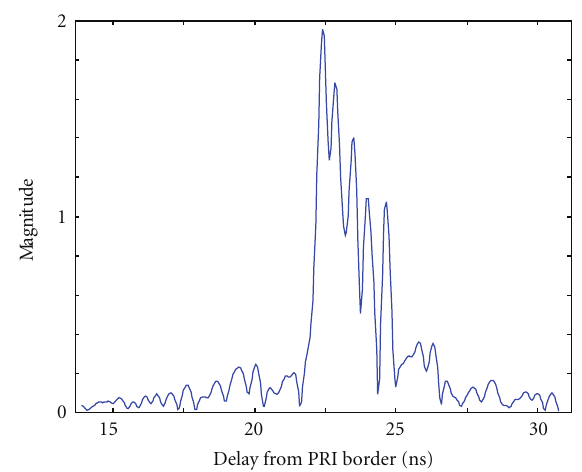
Figure 10: Pulse-compressed output signals from broadside in out- door experiments.